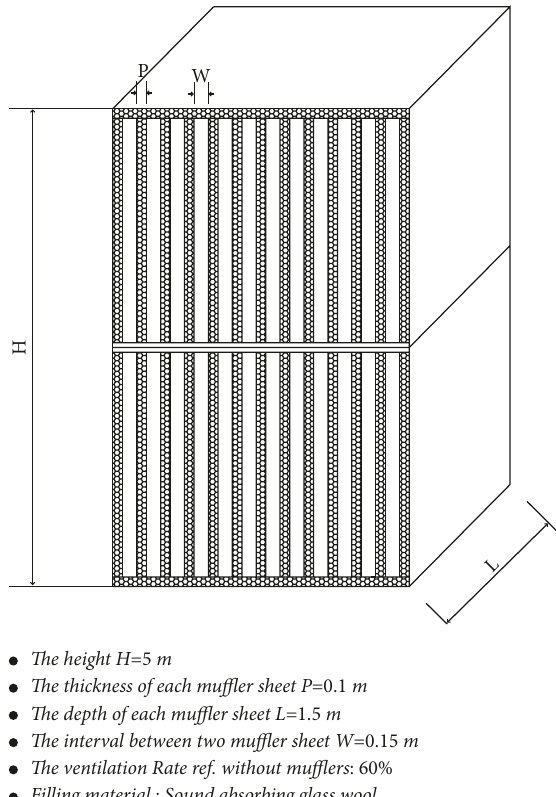
Figure 17: Detailed parameter for splitter mufflers.